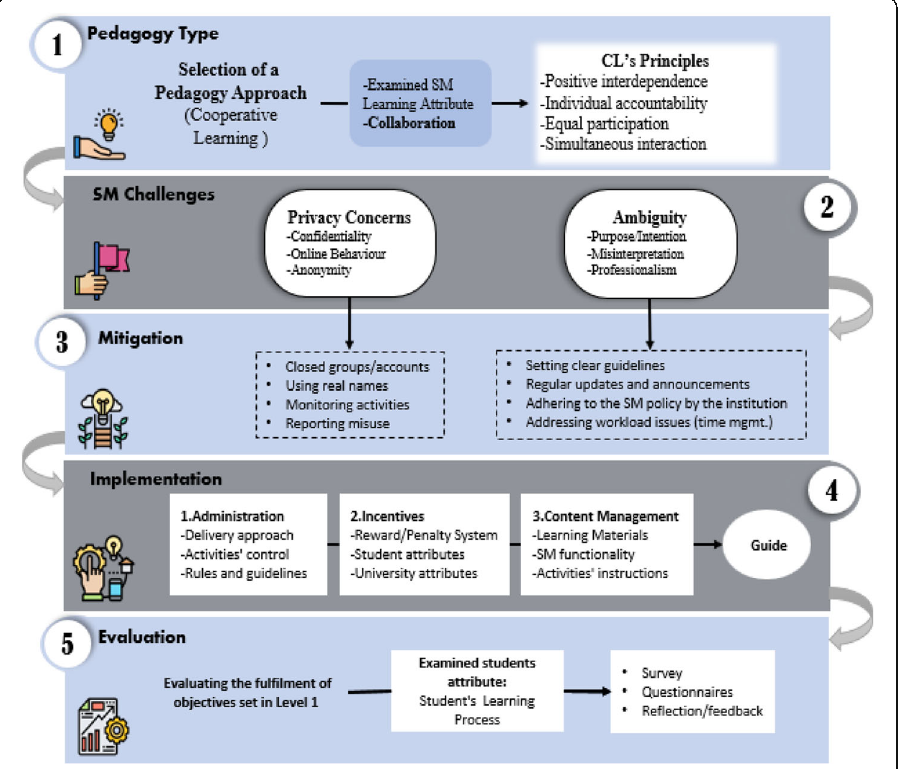
Fig. 2 The proposed SM integration